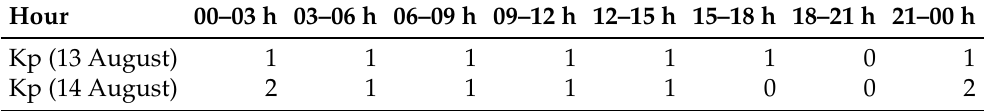
Table 7. Hourly Kp and 13,14 August